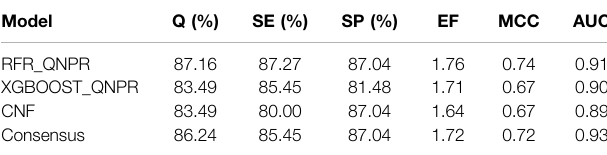
TABLE 3 | Performances of models on external validation. Model